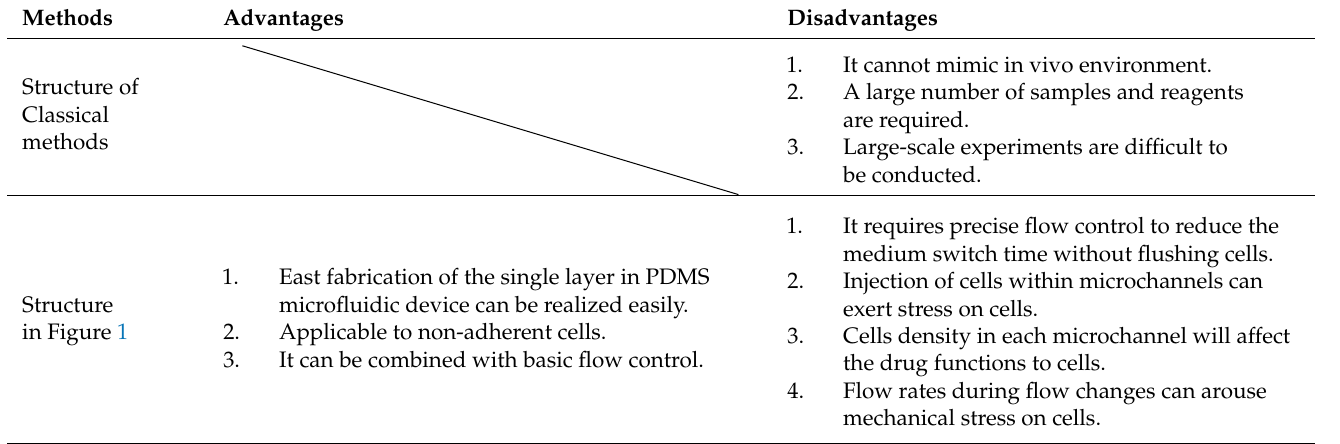
Figure 2. 2D culture microfluidic devices. ( A ) Two-compartment structure designed. ( B ) Three- compartment structure (soma, axonal, axonal). ( C ) Fourcompartment structure (glial, glial, axonal, somal) for controlling the injection of solutions. ( D ) Five-compartments structure for drug screen. ( E ) The structure of six axon compartments sharing common reservoir for high-throughput batch culture. ( F ) Circular structure, inner circle: somal compartments, outer circle: axonal compartments. Table 2. Advantages and disadvantages of different cell culture structures.